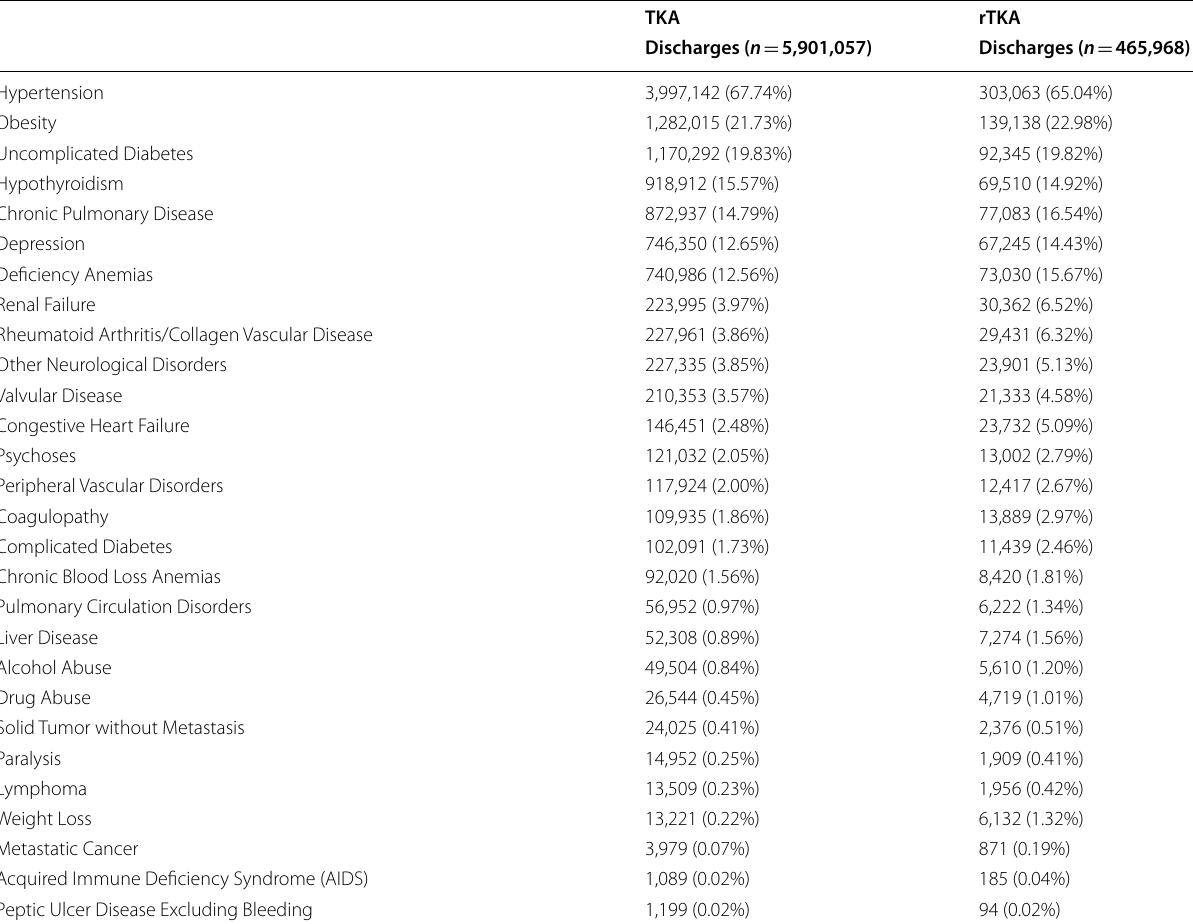
Table 2 Elixhauser comorbidity profile collected from the NIS database of patients undergoing TKA and rTKA from 2006 to the third quarter of